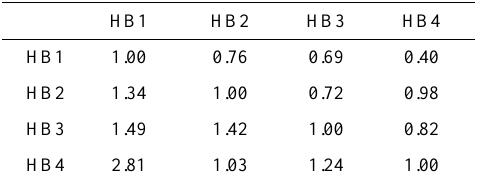
Table 7. Crisp Matrix Barriers to Process/Business